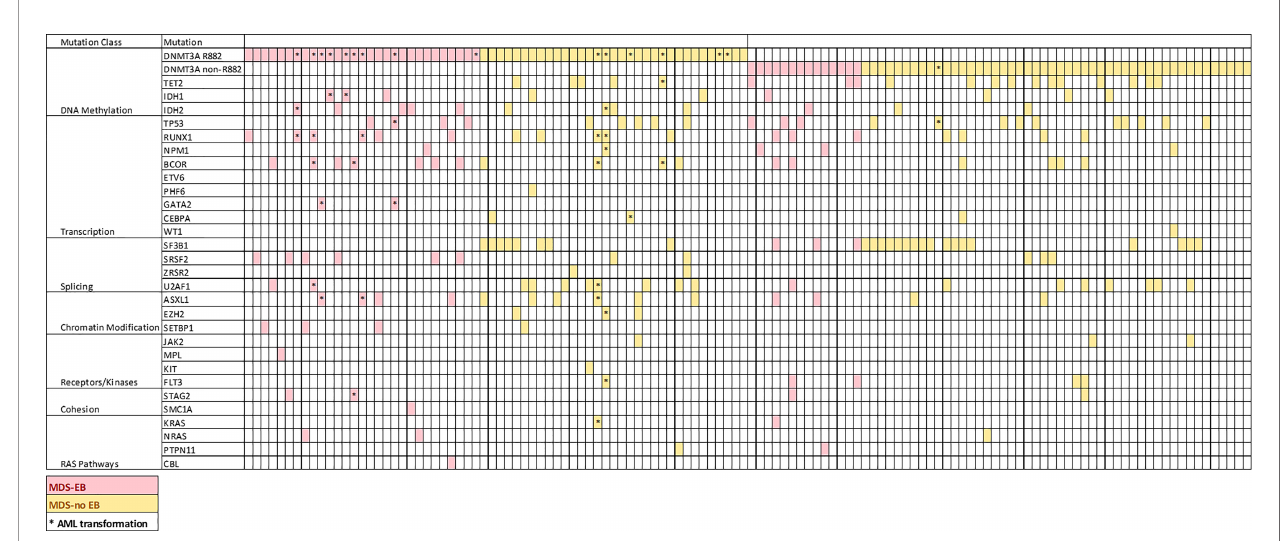
FIGURE 3 | Distribution of coexisting mutations of genes commonly mutated in AML and MDS ordered by gene function. Each column represents a